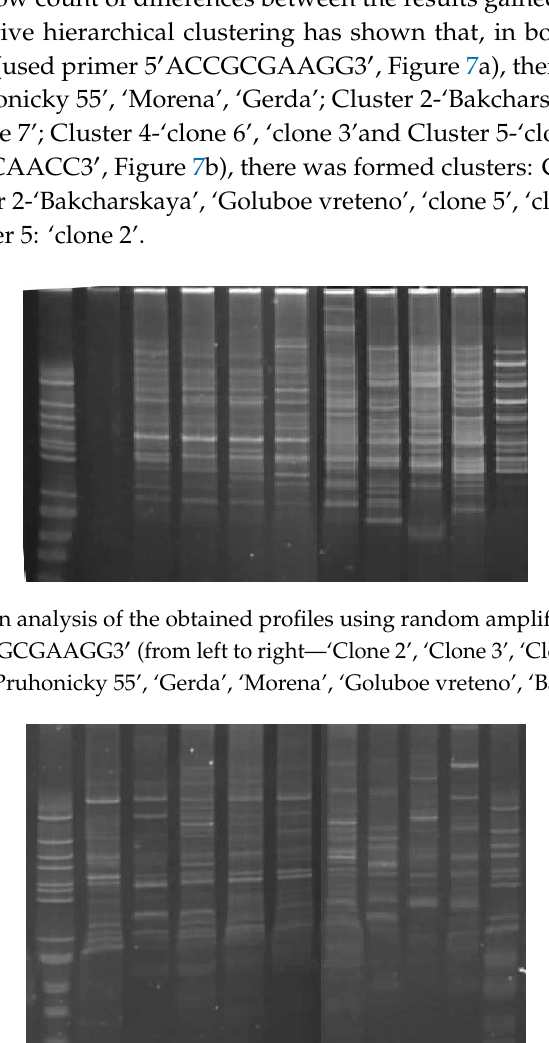
Figure 6. Amplification analysis of the obtained profiles using RAPD primer 5 ′ GGACCCAACC3 ′ (from left to right—‘Clone 2’, ‘Clone 3’, ‘Clone 5’, ‘Clone 6’, ‘Clone 7’ (Slovak Republic), ‘Pruhonicky 55’, ‘Gerda’, ‘Morena’, ‘Goluboe vreteno’, ‘Bakcharskaya’). Table 1. Comparison of the lengths of the amplified fragments using the 5 ′ ACCGCGAAGG3 ′ RAPD primer.